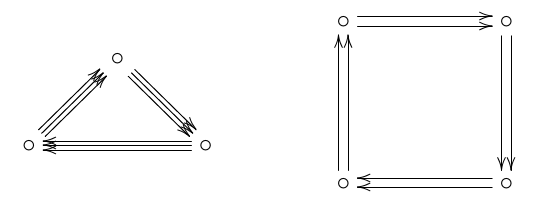
Figure 1 . Some well-known examples of quivers from